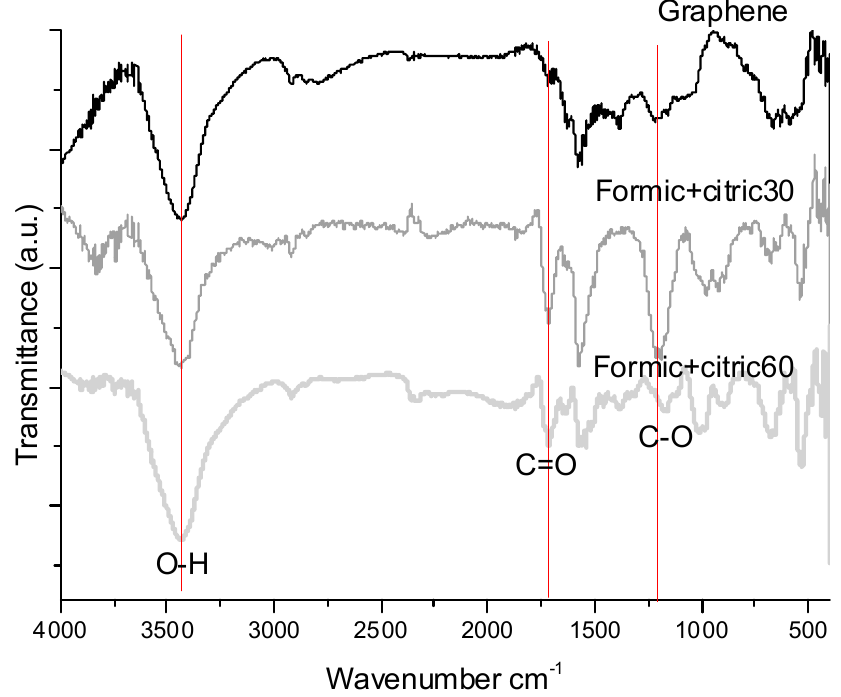
Figure 2. FT–IR spectra of the unmodified graphene and modified graphene with Formic+Citric30, Formic+Citric60.